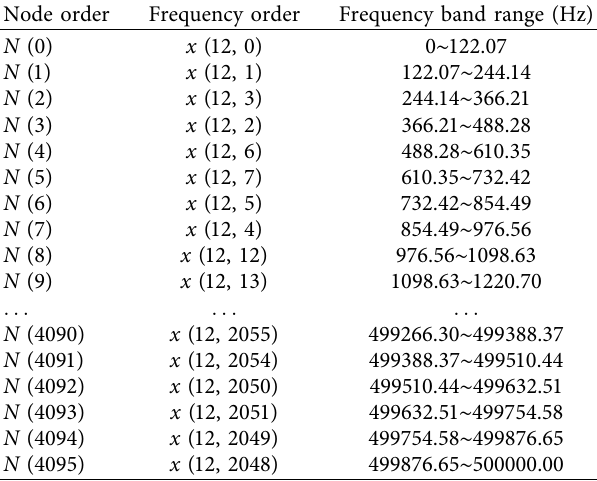
Figure 6: Variation tendencies of dominant frequency.